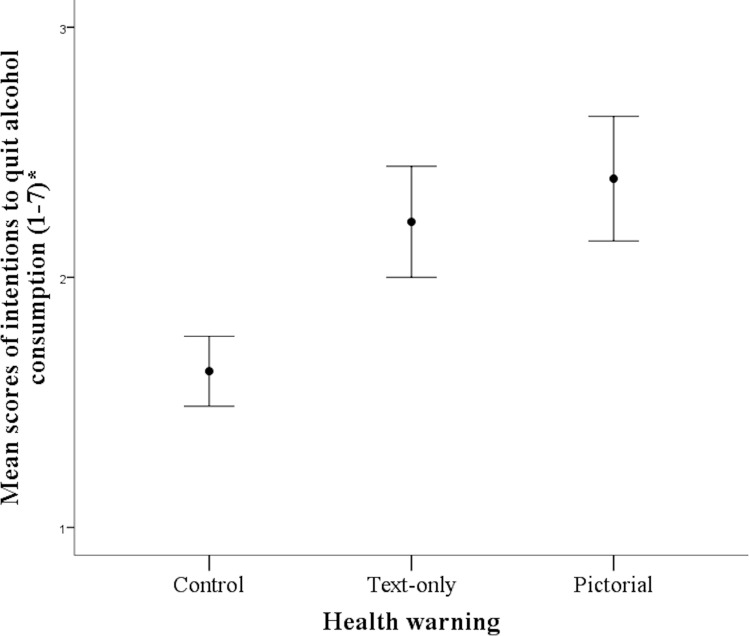
Mean scores of intentions to quit alcohol consumption as a function of health warning.Error bars represent standard errors of the mean.